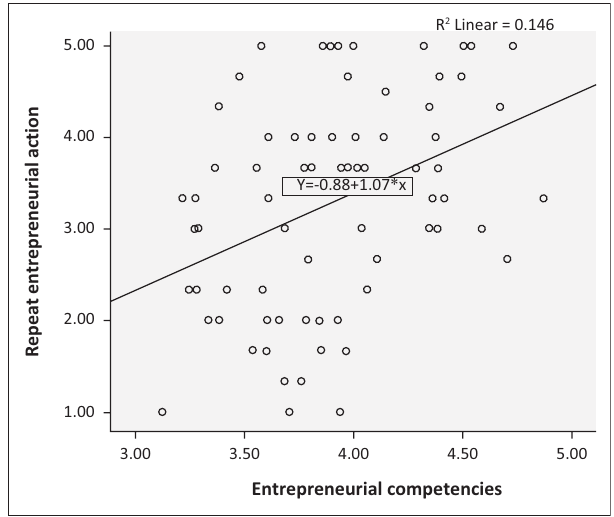
FIG URE 8: Scatter plot showing the relationship between recurring entrepreneurial action and entrepreneurial TABLE 6: Results of Pearson’s product–moment correlation. Spearman’s rho Variable